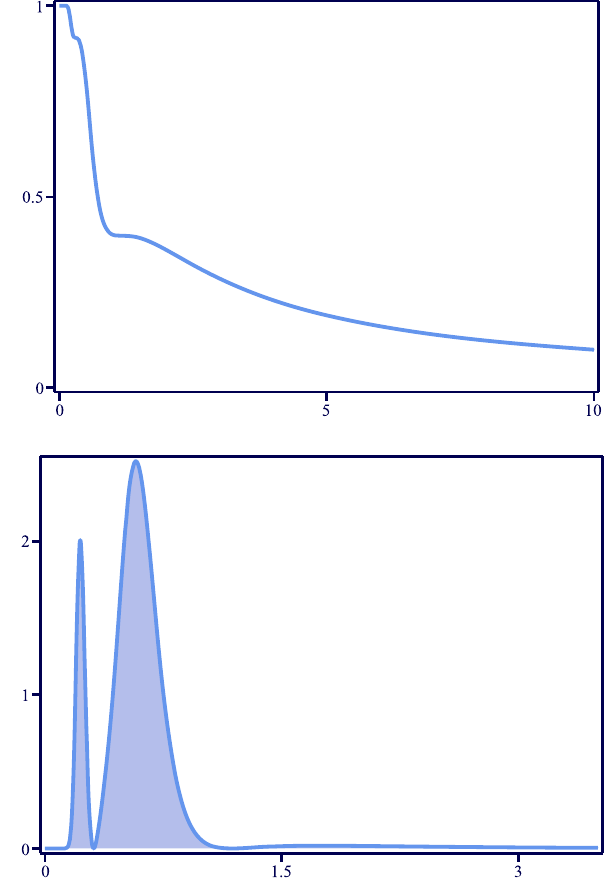
Fig. 8 The top and bottom panels show the solution (57) and the the energy density in Eq. (58) for n = 2 and α = 0 . 3, respectively